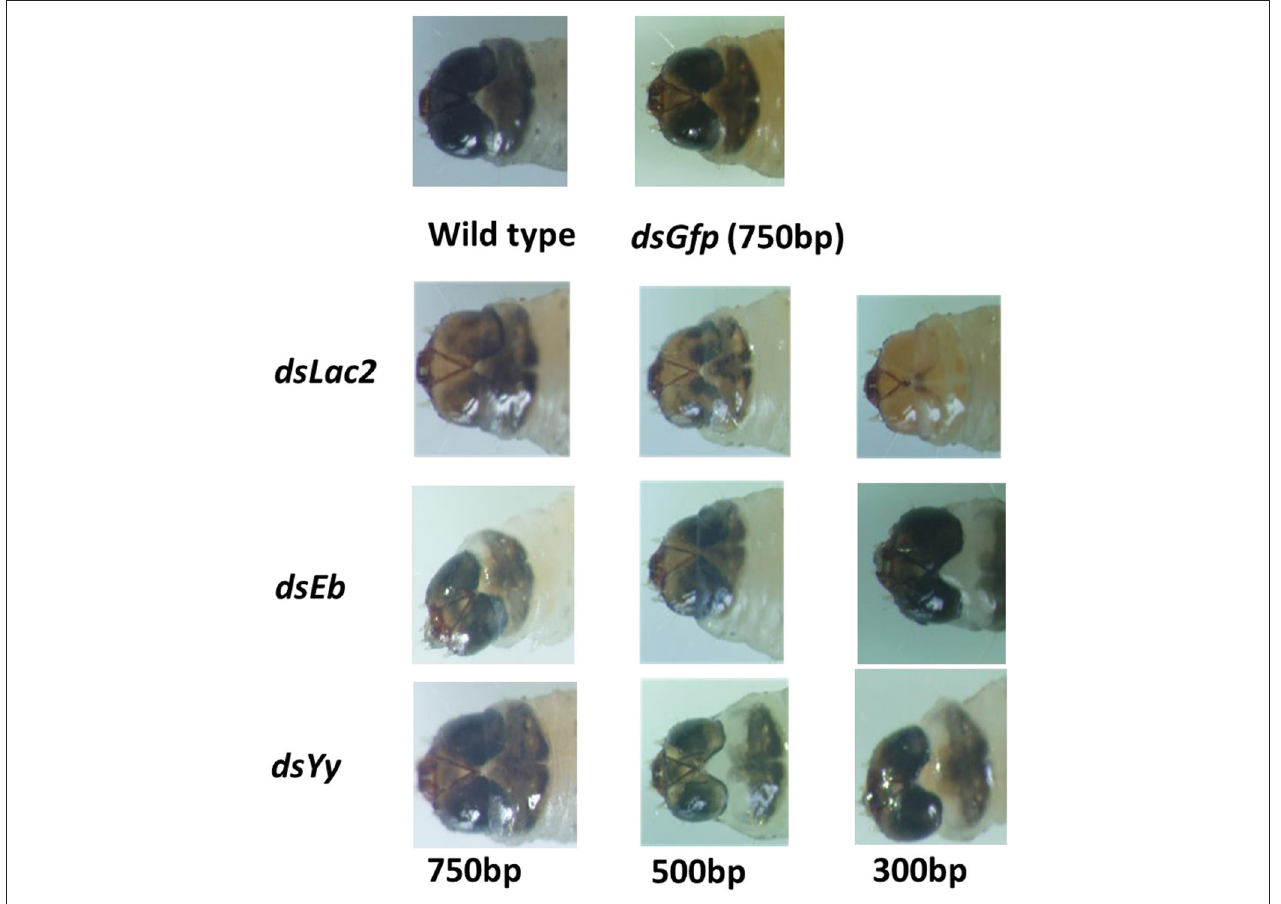
FIGURE 9 | Effect of dsRNA length on feeding RNAi efficiency. Feeding 5 ug/ml 300 bp long of Lac2 dsRNA induced easily identifiable pigmentation defects in Lac2 RNAi.